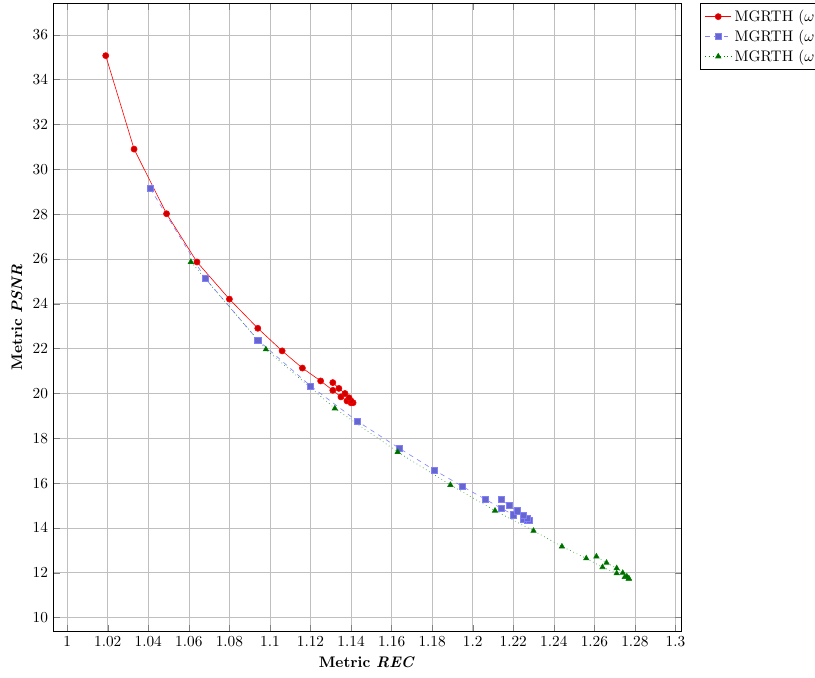
Figure 4. Ratio between PSNR and REC.